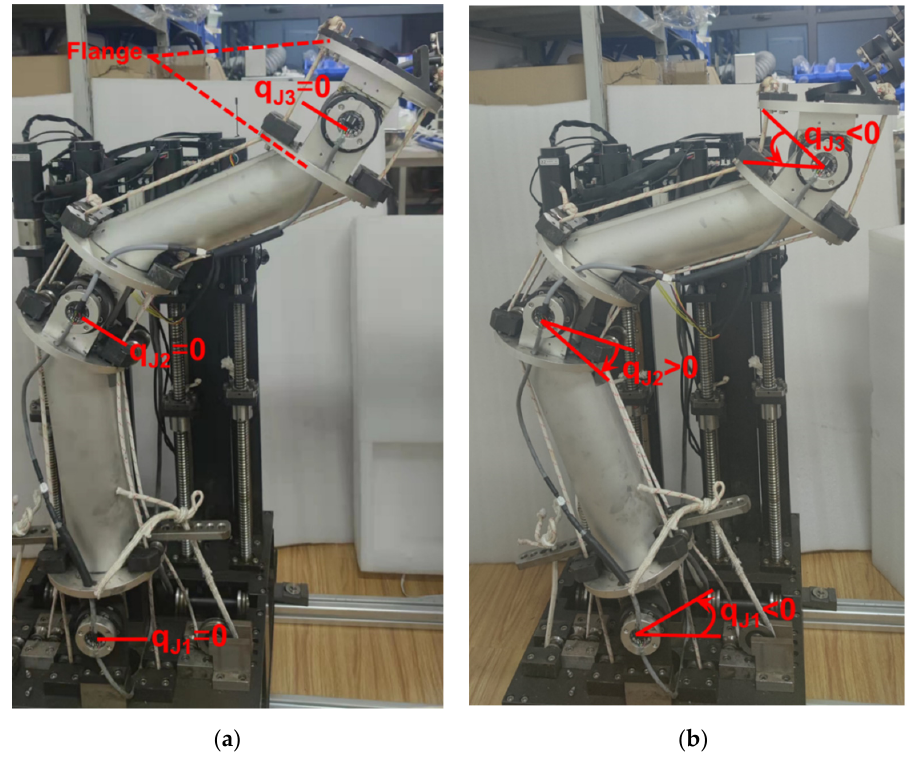
Figure 4. ( a ) The cable-driven manipulator at the state of zero joint angles; ( b ) the cable-driven manipulator at the state of non-zero joint angles.